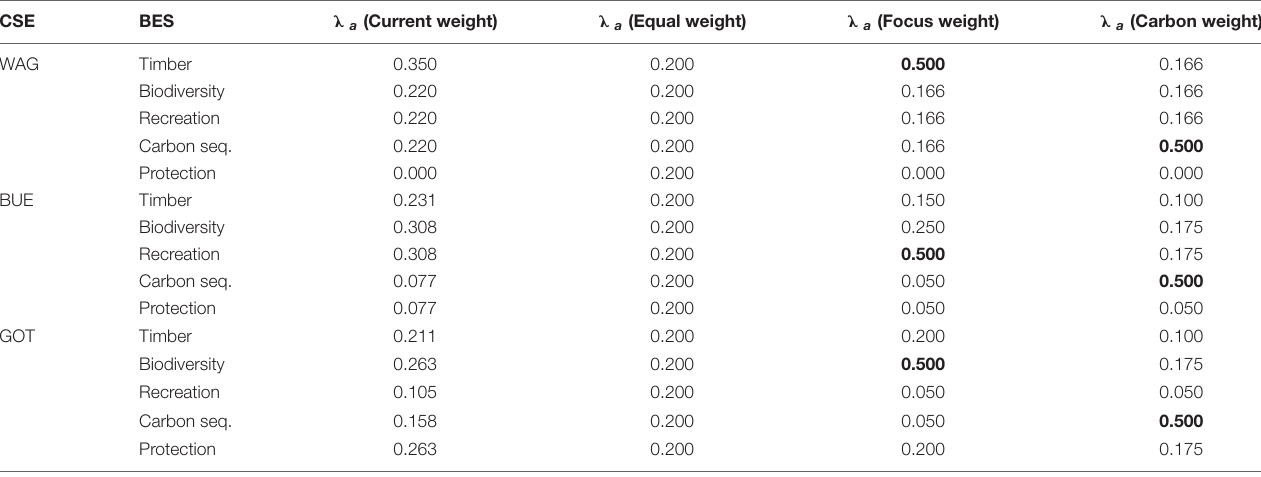
Numbers marked in bold indicate the weighting focus of each CSE (i.e., WAG, timber; BUE, recreation; GOT, biodiversity).